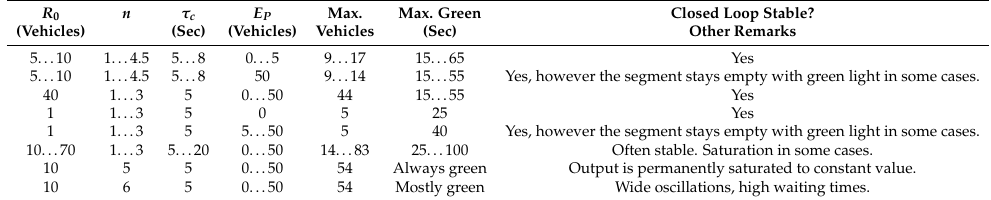
Table 1. Time response simulation